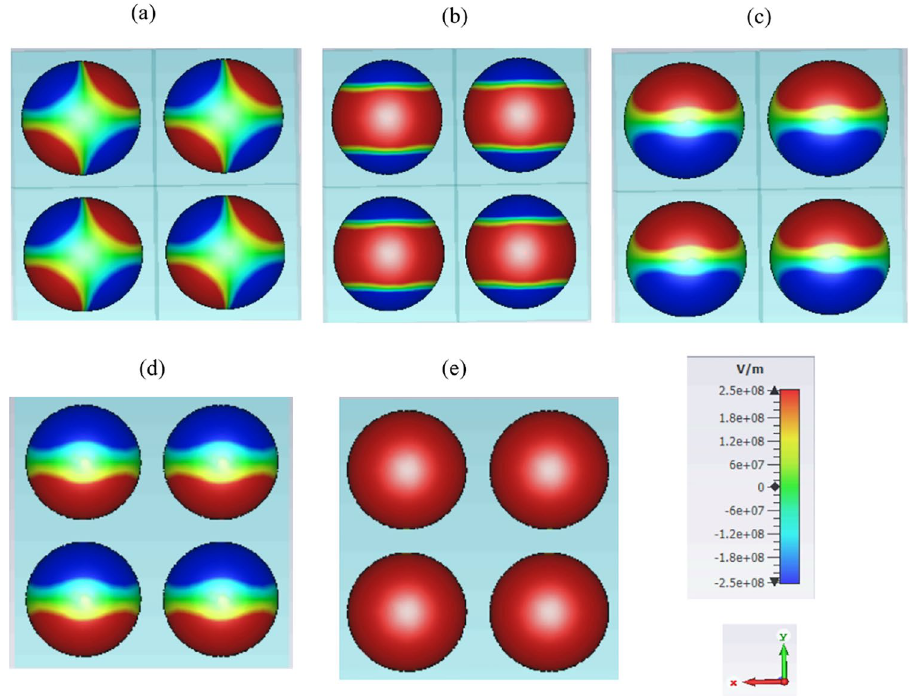
Figure 2. Spatial distribution of the electric field for the structure in Fig. 1 at the reflection peak (30.62 THz) ( a )